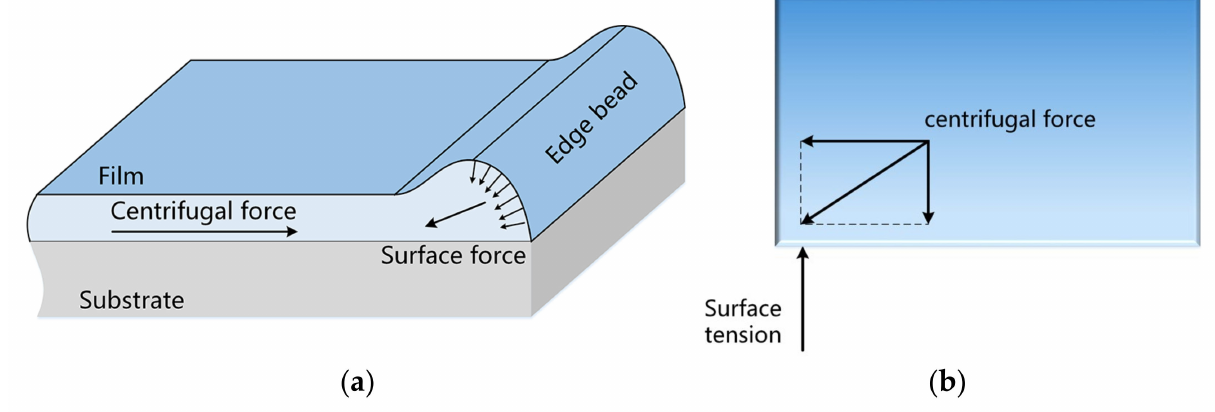
Figure 11. Force analysis of the film free surface: ( a ) Section view; ( b ) Top view.